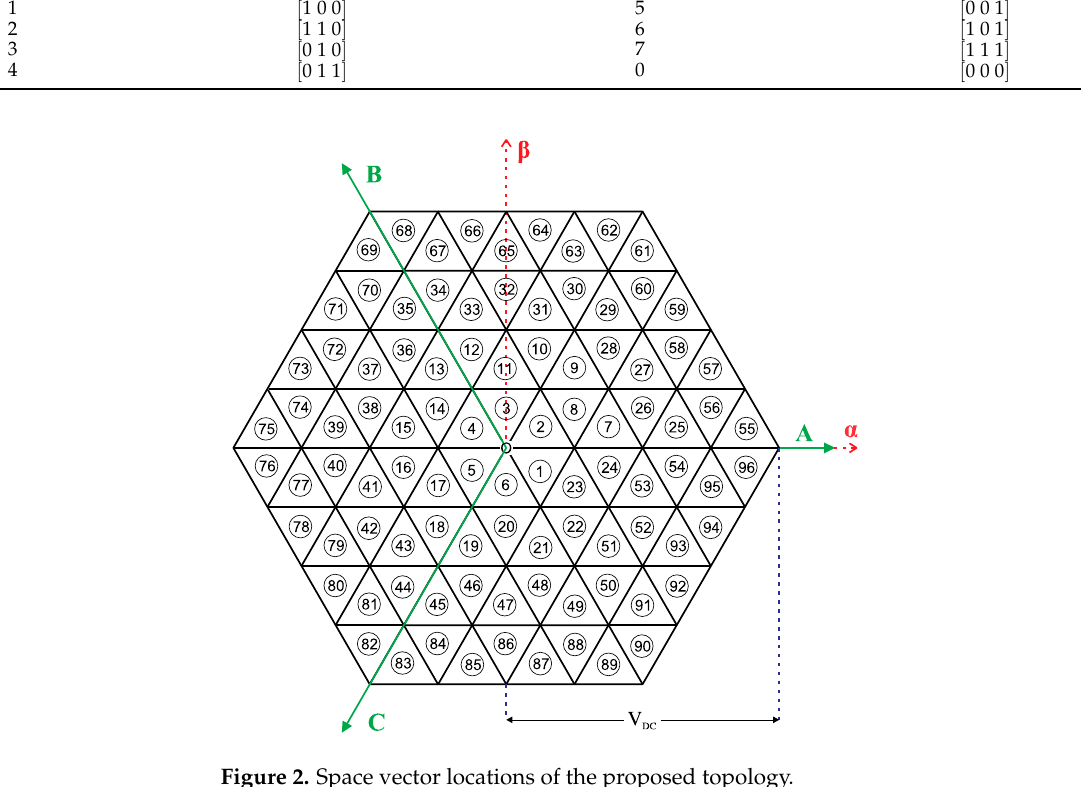
Table 2. Voltage vectors for zero common-mode